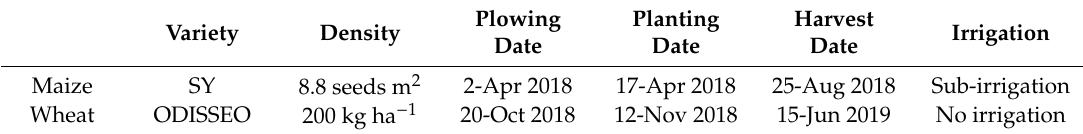
Figure 1. Experimental field: ( a ) soil resistivity map ( Ω m 2 ) 0–50 cm depth profile and localization of the 36 soil samples collected in the field; ( b ) localization of the 20 experimental plots, based on the soil map and on contrasting areas of resistivity map (5 plots for each soil class). Table 1. Agronomic details of field experiments for maize in 2018 and wheat in 2019.